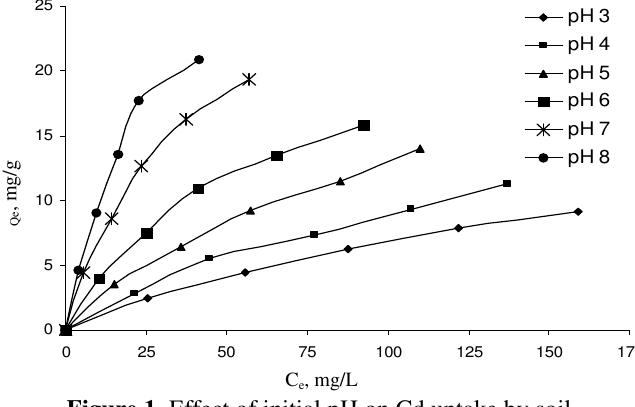
Figure 1 . Effect of initial pH on Cd uptake by soil.